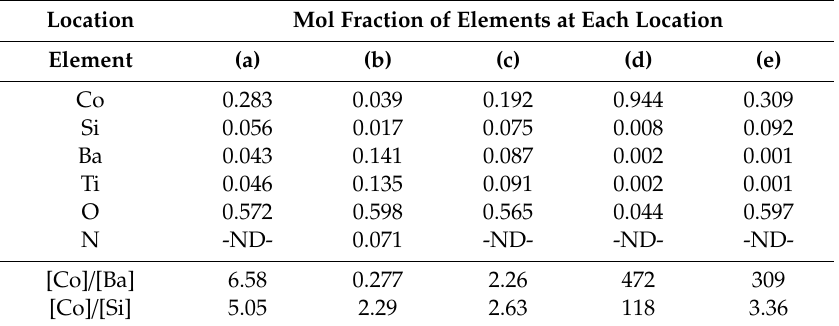
Table 11. Composition and morphology of the composite {Co / Si = 2} / BT = 1 / 4 catalyst at various locations shown in Figure 31. Location (a) refers to the whole area. Nitrogen was not detected (ND) except in the spot analysis of the location